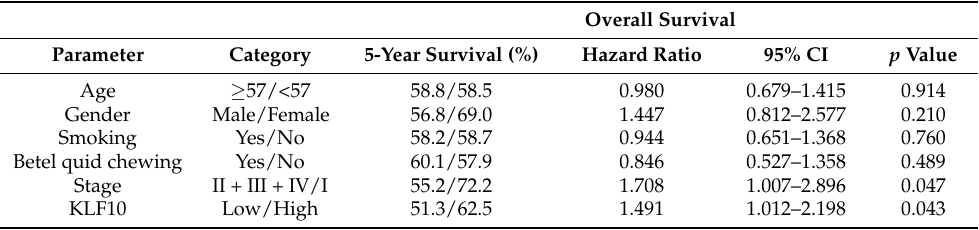
Table 2. Univariate analysis of the influence of various parameters on the overall survival of oral cancer patients.